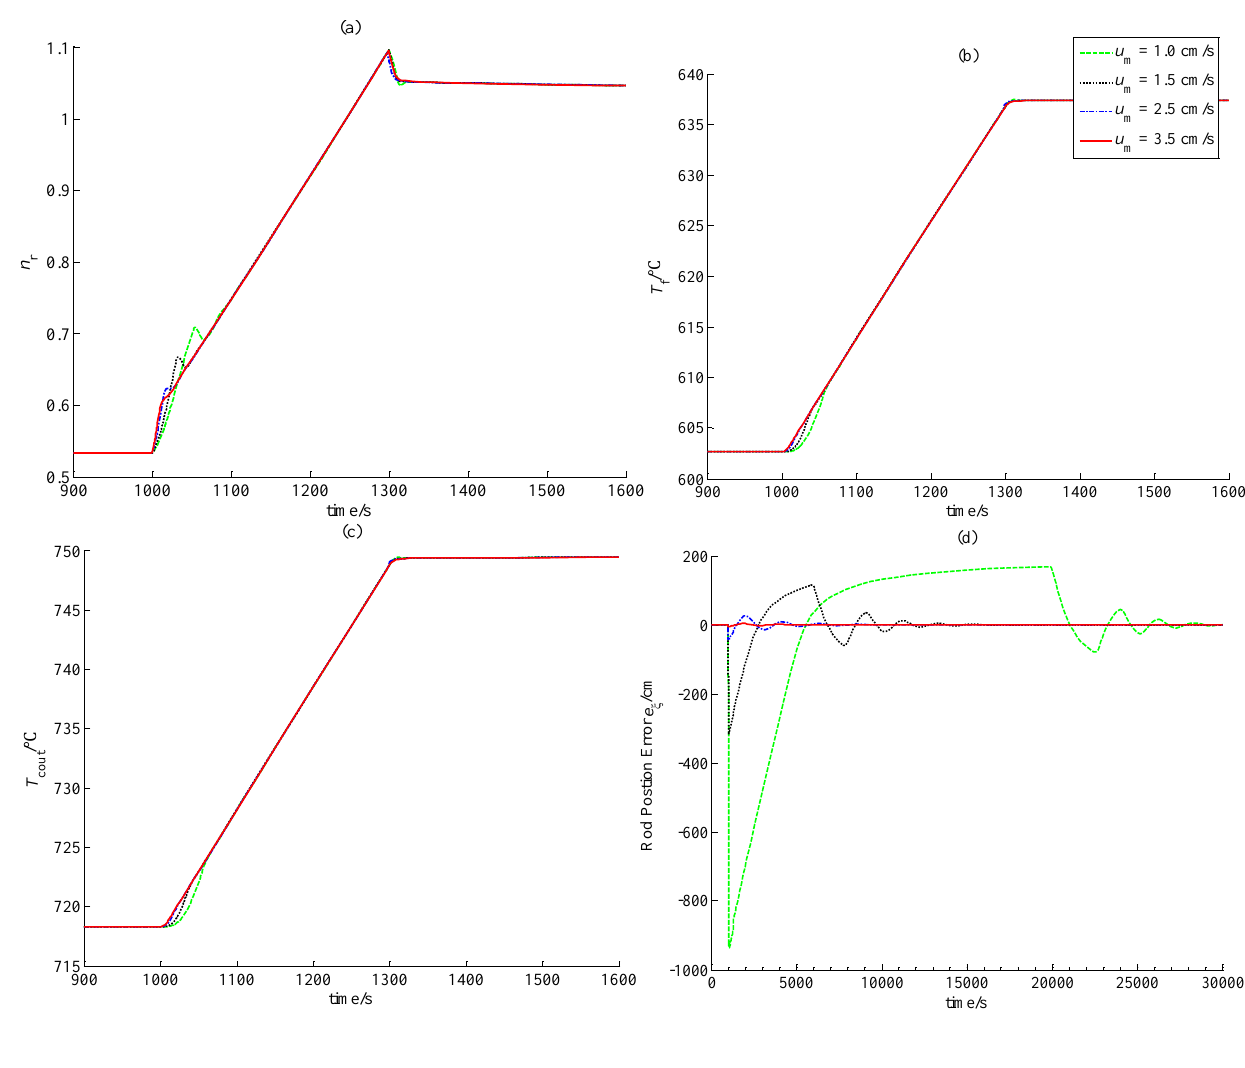
Figure 4. Simulation results in case A: ( a ) relative nuclear power n r ; ( b ) average fuel temperature T f ; ( c ) outlet helium temperature T cout ; ( d ) error signal e ξ between ξ and ξ d ; ( e ) designed control rod speed signal u and ( f ) compensating signal u